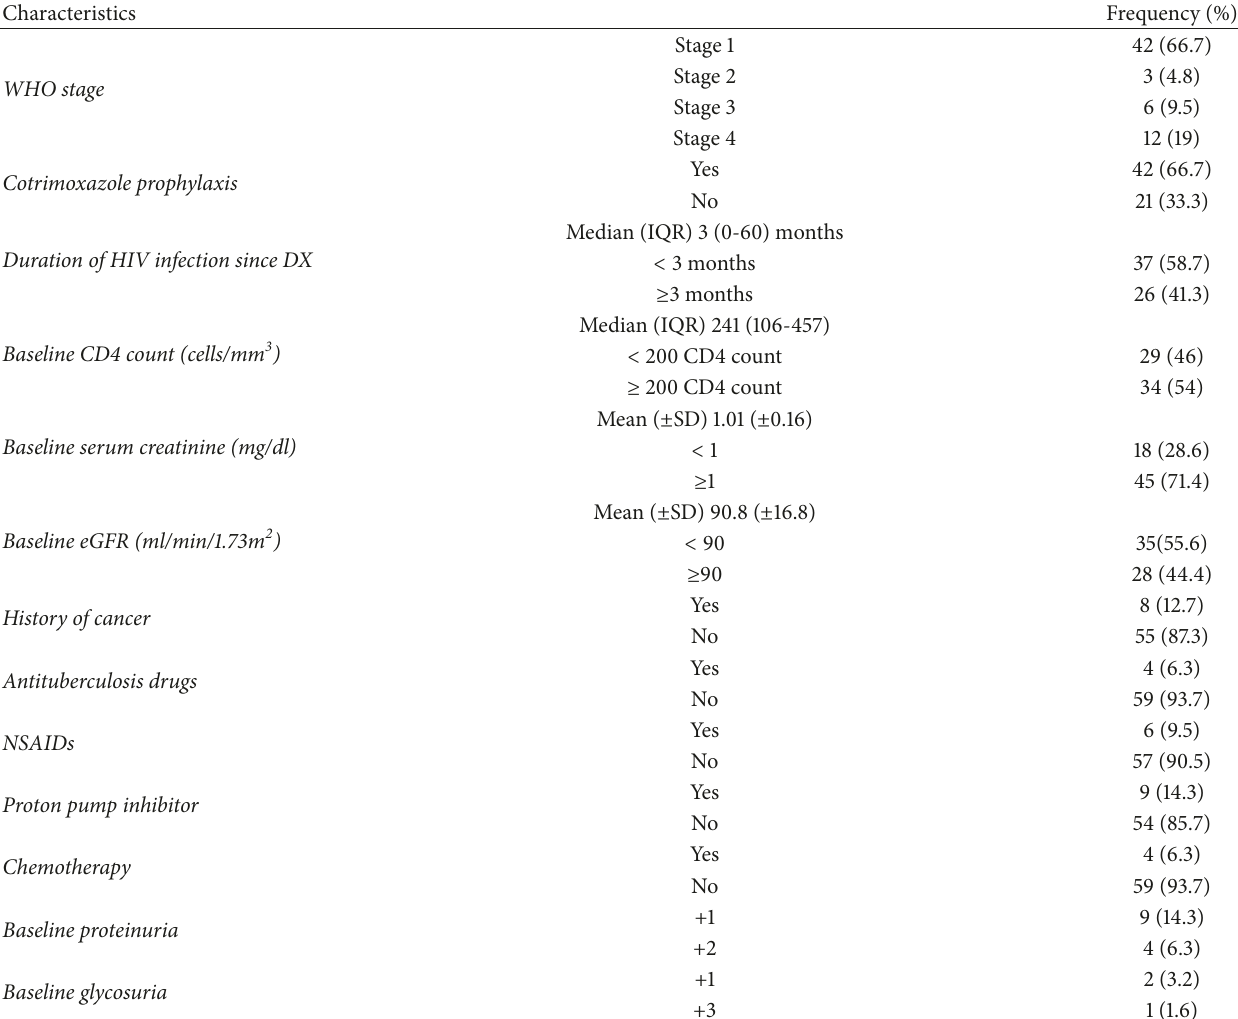
Table 2: Baseline clinical characteristics of study participants in TASH [n = 63].